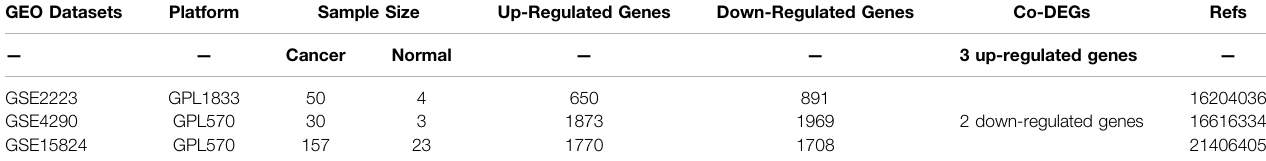
TABLE 1 | The primary characteristics of three GEO datasets on gene expression pro fi ling via microarray. GEO Datasets